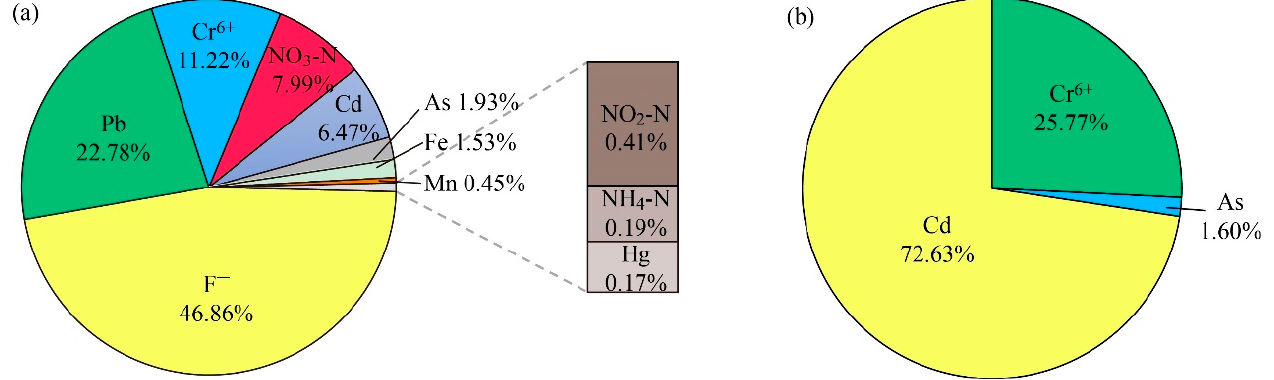
Figure 4. Contributive ratios of contaminants in groundwater to health risks ( a ) non-carcinogenic risk; and ( b ) carcinogenic risk.